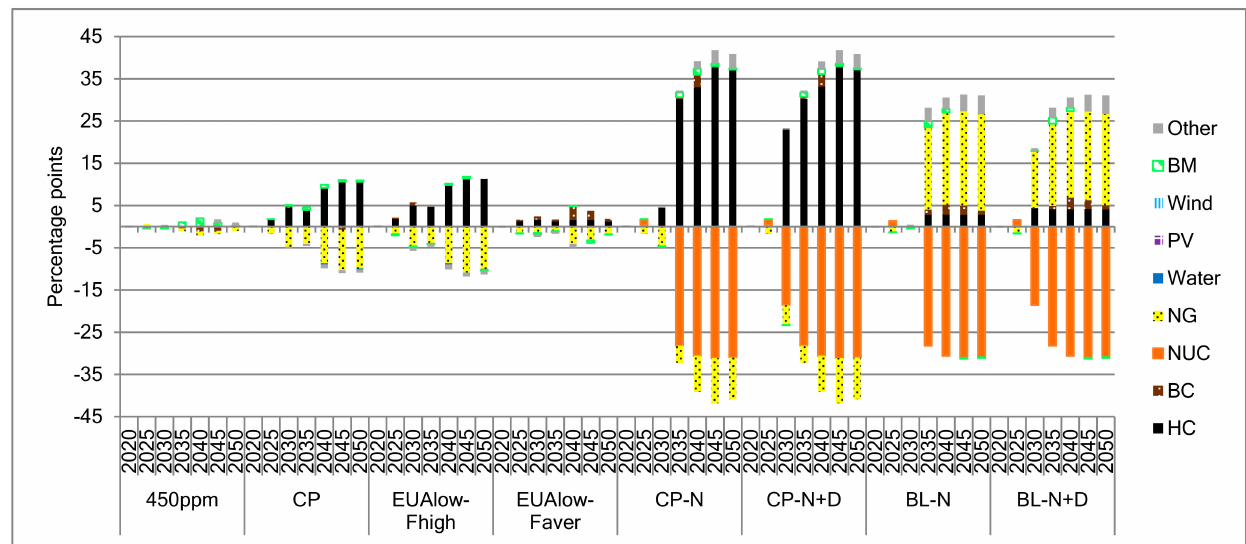
Figure 6. Fuel mix for electricity production in TEL2’s scenarios compared to TEL2 BL, percentage point difference. Note: HC—hard coal, BC—brown coal, NUC—nuclear, NG—natural gas, BM—biomass and